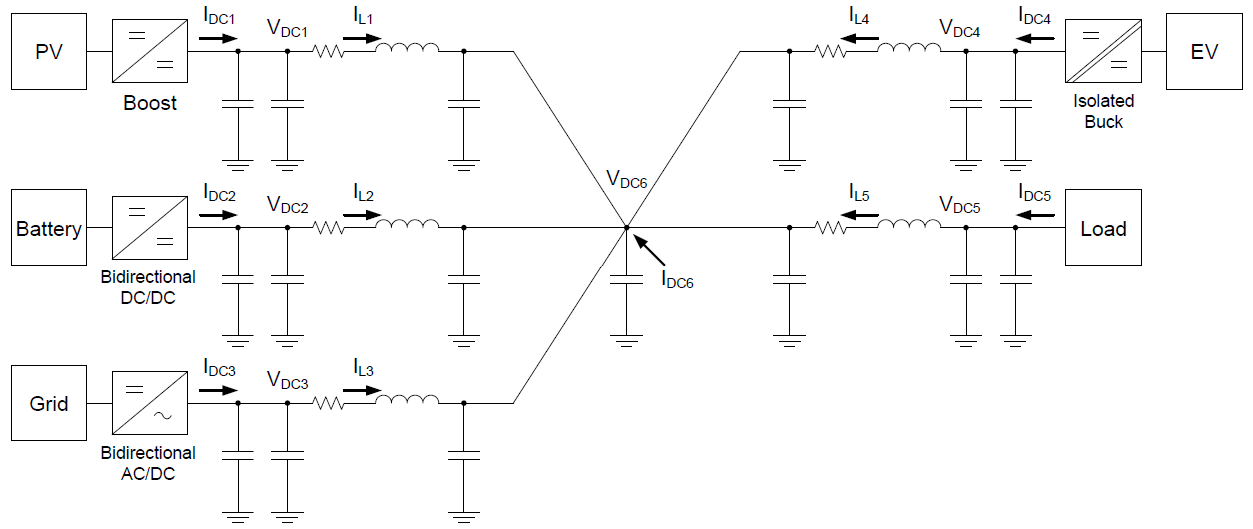
Figure 12. State space model of DC nanogrid adapted from